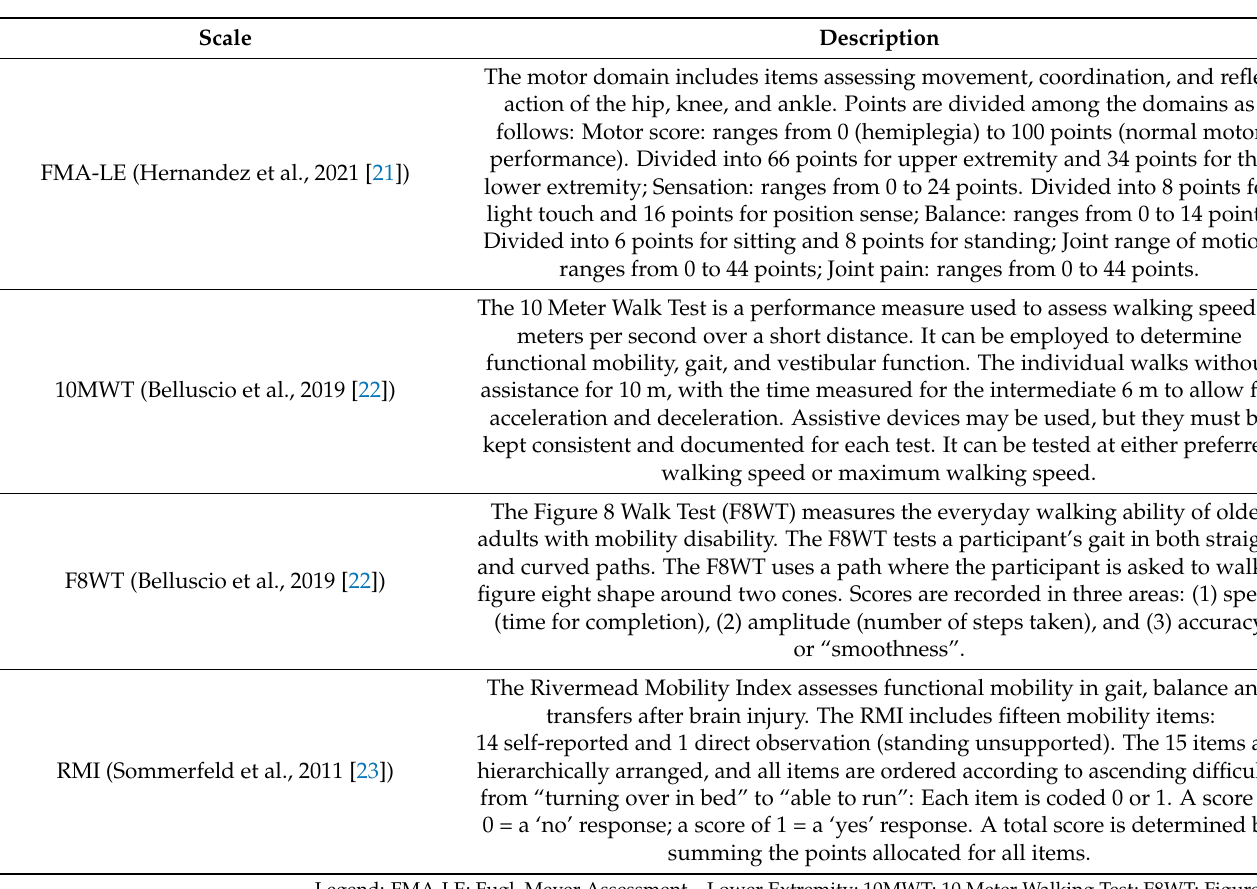
Table 3. Description of lower limb assessment